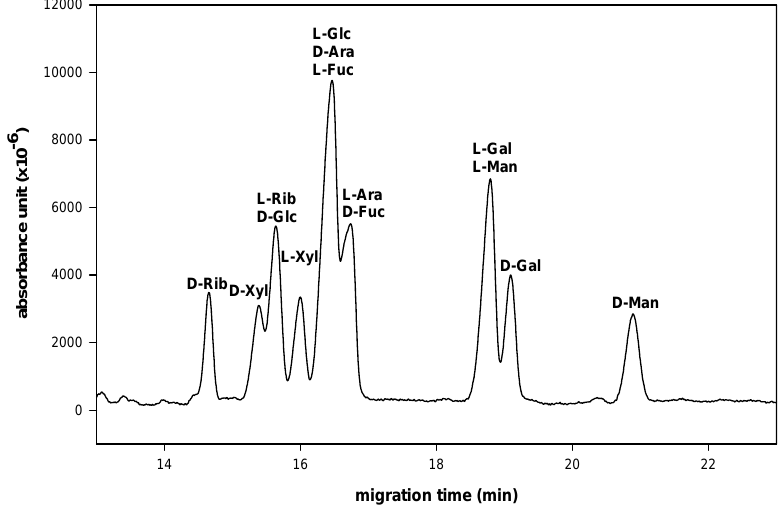
Figure 4. Simultaneously analysis sugar composition and its D -, L -configuration in one inject. Enantioseparation condition was set as phosphate − sulfated −α− CD system with a 30/40.2 cm × 50 µm uncoated fused-silica capillary. (NaH sulfated −α− CD, 10 mg/mL at 15